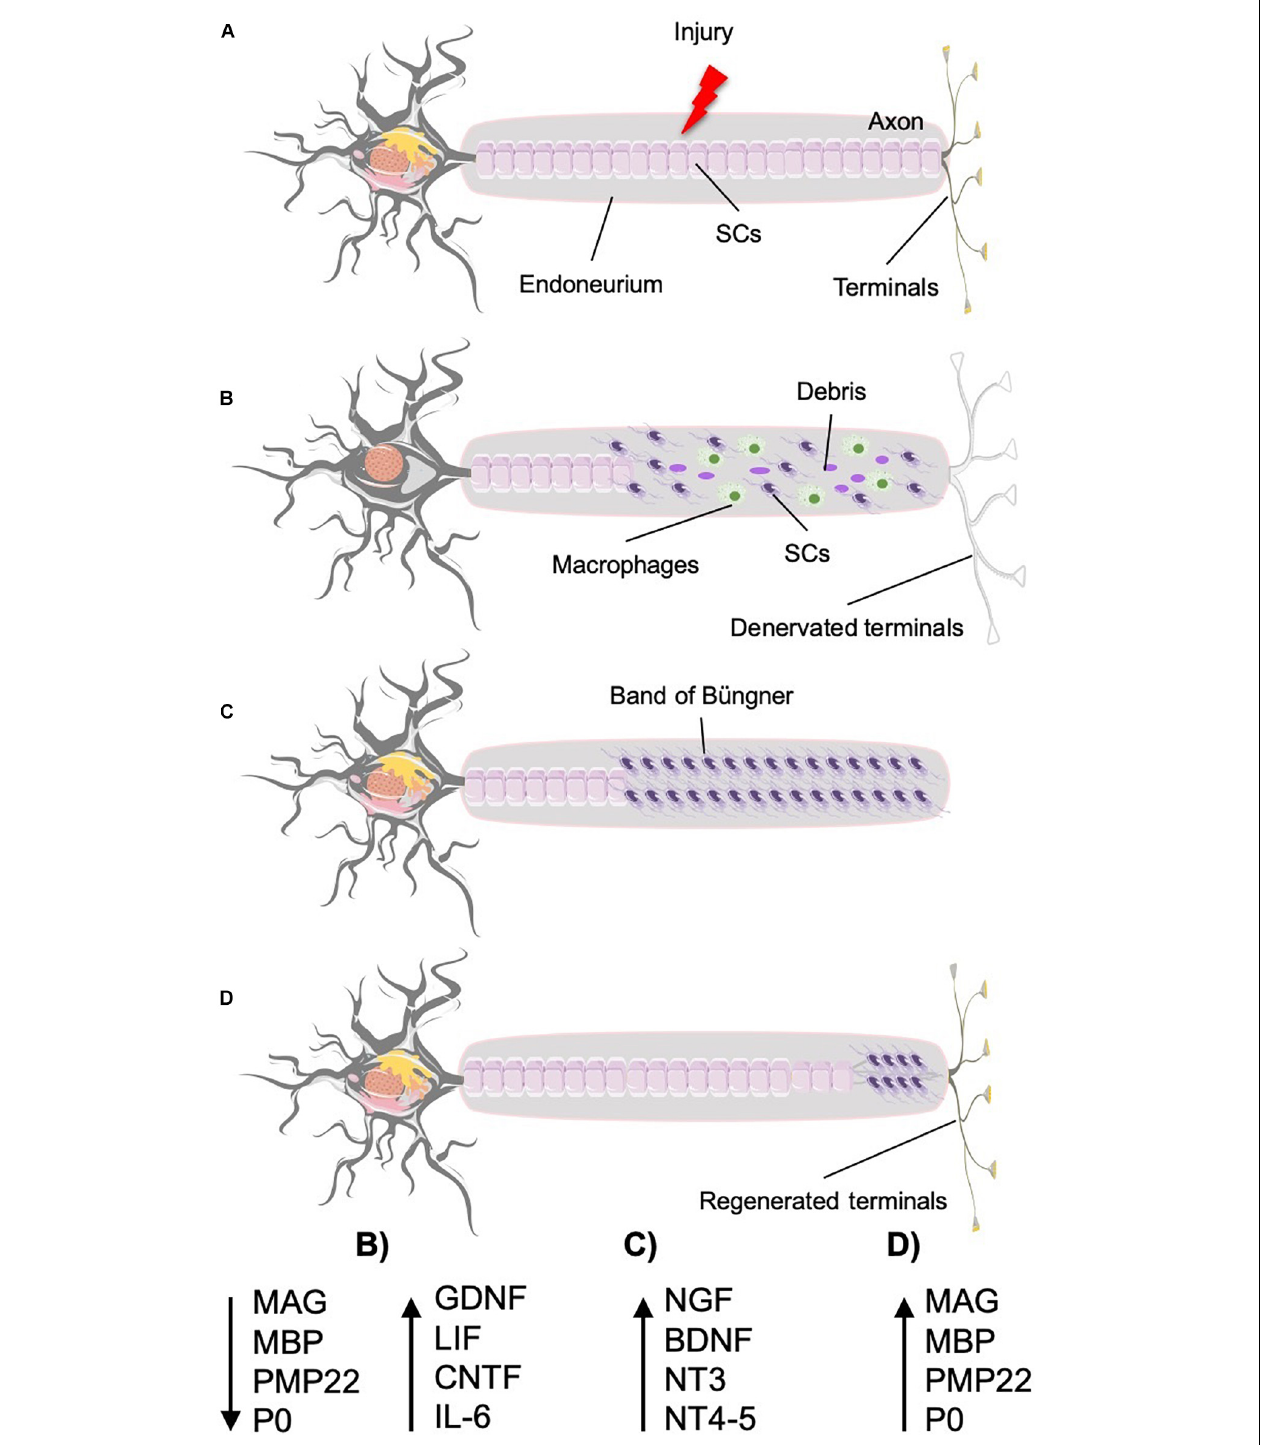
FIGURE 2 | Nerve injury and regeneration under ideal conditions. Time course and biomolecular processes. (A) Normal neuron that suffers an injury (crush or section) that triggers the regeneration process. (B) The proximal part undergoes retrograde degeneration and chromatolysis. The distal part suffers Wallerian degeneration, provoking the denervation of the target tissue and leaving the endoneurium clean for the axon to regenerate (MAG, MBP, PMP22, and P0 levels decrease, whereas GDNF, LIF, CNTF, and IL6 production increases). (C) Schwann cells form bands of Büngner to guide the regenerated axons into the distal endoneural tube (with high levels of NGF, BDNF, NT3, and NT4–5). (D) The axon grows in contact with the surfaces of the Schwann cells toward the target organ. As the axons grow, the Schwann cells start the remyelination process, producing the myelin-associated molecules (MAG, MBP, PMP22, and P0 return to their initial